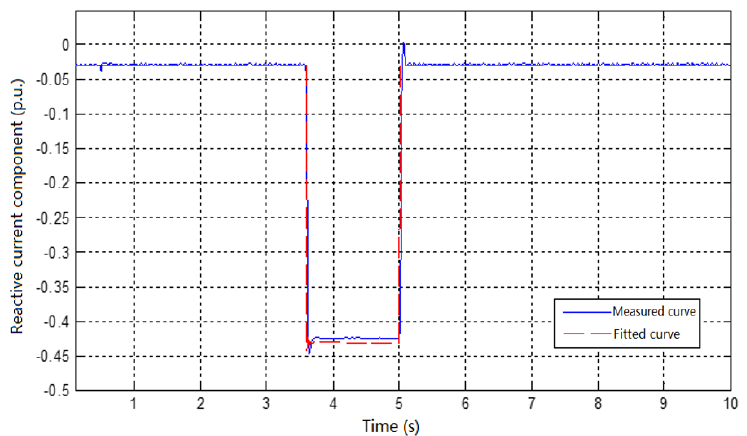
Figure 14. Active power fitted curve of large disturbance of grid voltage. Electronics 2020 , 9 , x FOR PEER REVIEW